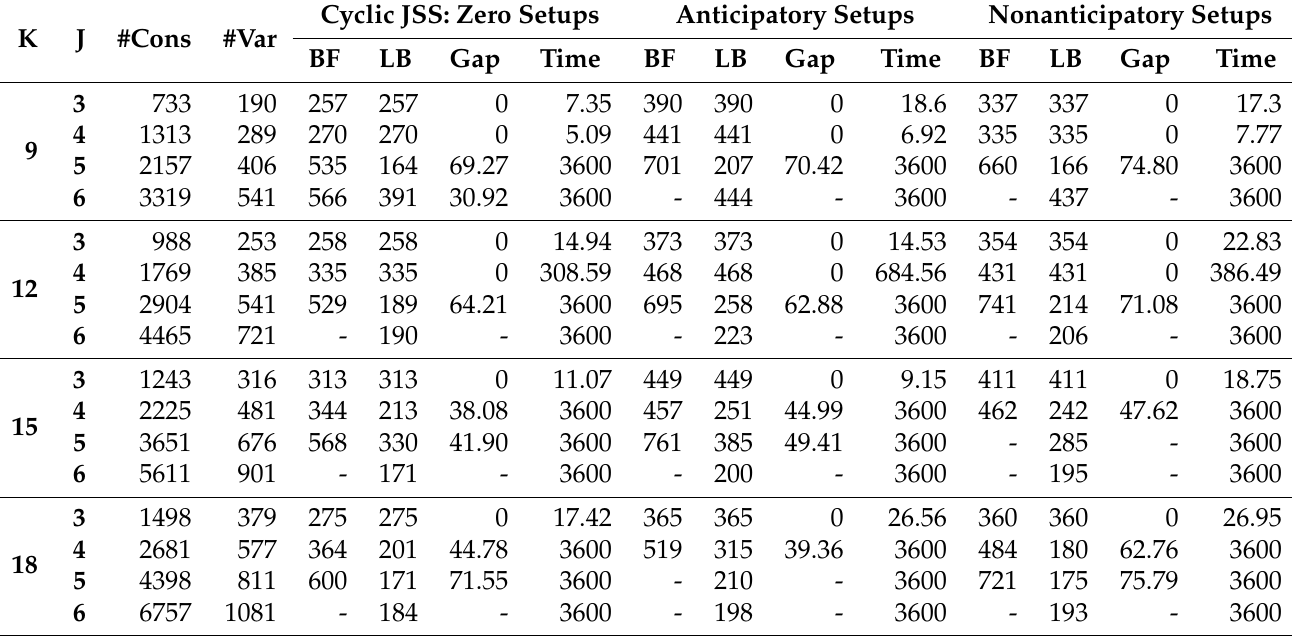
Table 3. The performance of proposed MIP approaches on the test problem instances ( #Cons: number of constraints; #Var: number of variables; BF: best found; LB: lower bound